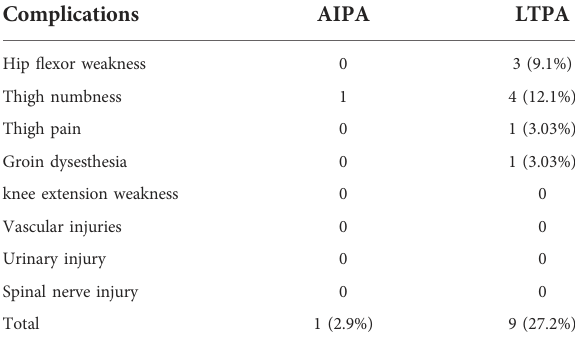
TABLE 5 Approach-related